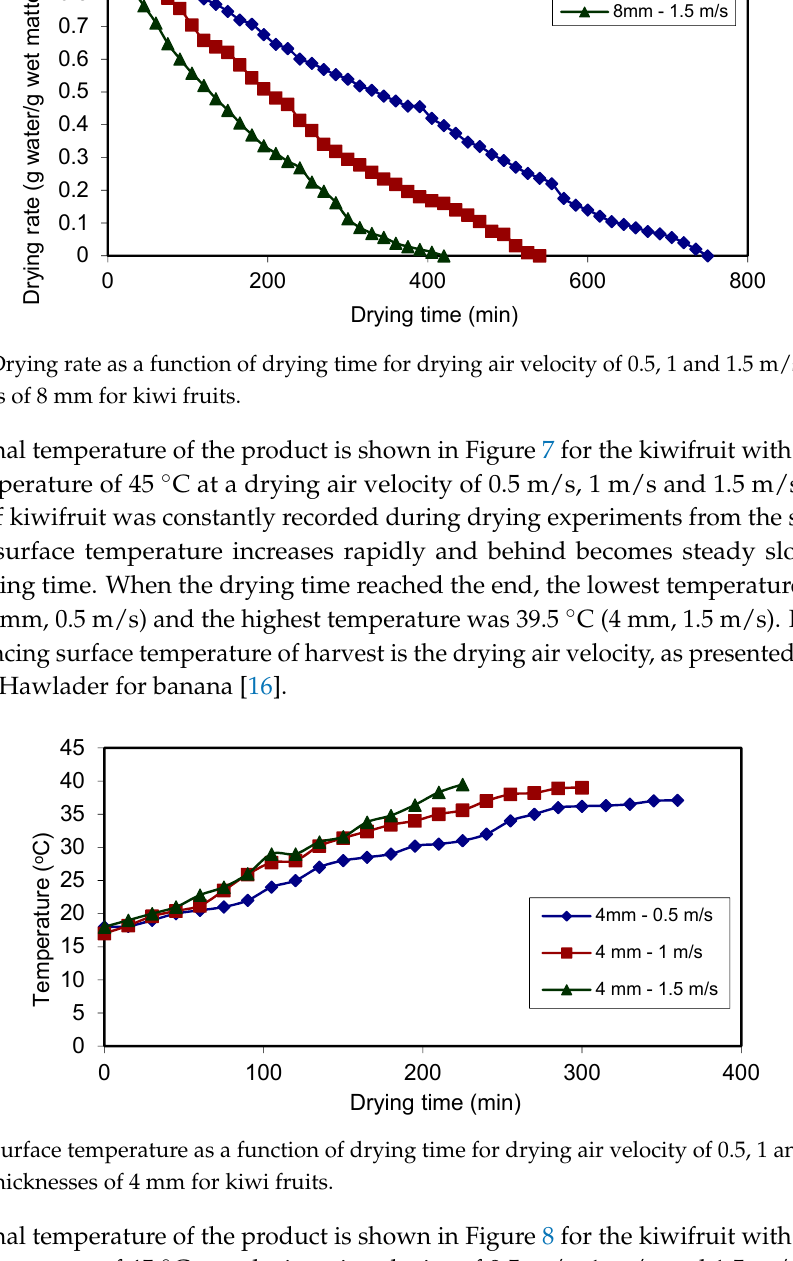
Figure 5. Drying rate as a function of drying time for drying air velocity of 0.5, 1 and 1.5 m/s and slice thicknesses of 4 mm for kiwi fruits.